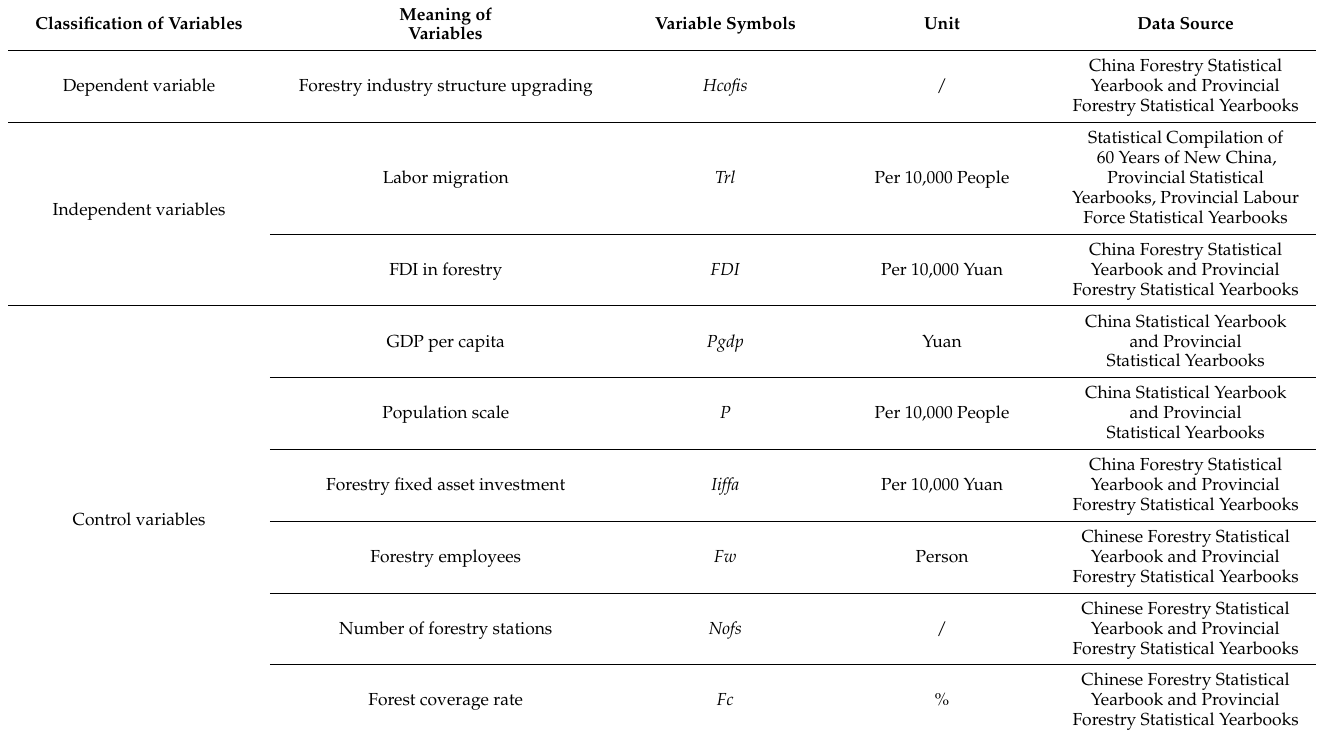
Table 3. Illustrative table of variable indicators.